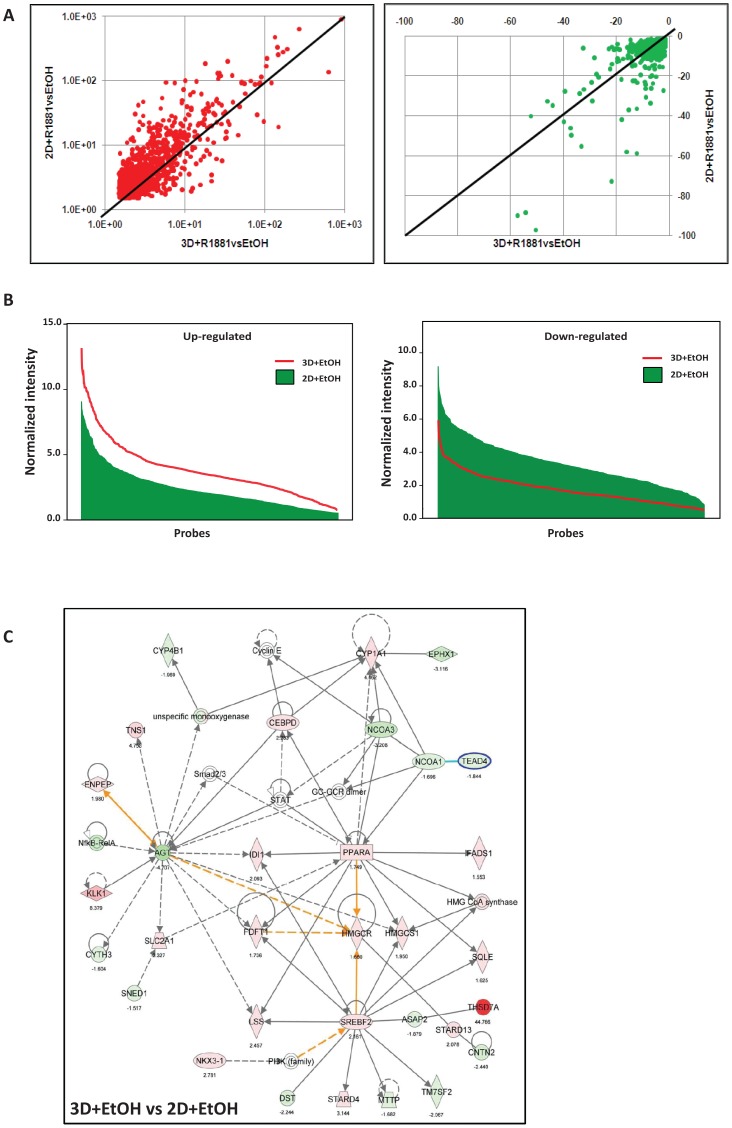
Microarray expression profile of androgen regulated genes in 2D and 3D LNCaP cell cultures.(A) Comparison of the fold change in expression levels of 1165 up-regulated (red) and 1697 down-regulated androgen-responsive genes (green) in LNCaP 2D and 3D cultures treated with 1 nM R1881 for 48 h relative to the corresponding EtOH controls. There is an increased magnitude of fold change in 2D cultures compared to 3D cultures upon R1881 treatment as represented by the population of red dots above the linear curve (left) and green dots below the linear curve (right). (B) Normalized intensity of probes representing 1469 differentially expressed genes that were up-regulated (left) and down-regulated (right) by androgen was compared between 2D+EtOH and 3D+EtOH cultures. The base line level is higher in 3D for the androgen up-regulated genes but lower in the androgen down-regulated genes when compared to 2D cultures. (C) Ingenuity Pathway Analysis (IPA) of the 1180 commonly regulated androgen-responsive genes. The network shows genes involved in lipid and steroid metabolism. Unbroken lines indicate direct interactions and broken lines indicate indirect interactions. The numbers and colors represent the fold change in expression levels (green = down-regulated and red = up-regulated) observed in the comparison of the ethanol controls of the 2D and 3D cultures (3D+EtOHvs2D+EtOH).